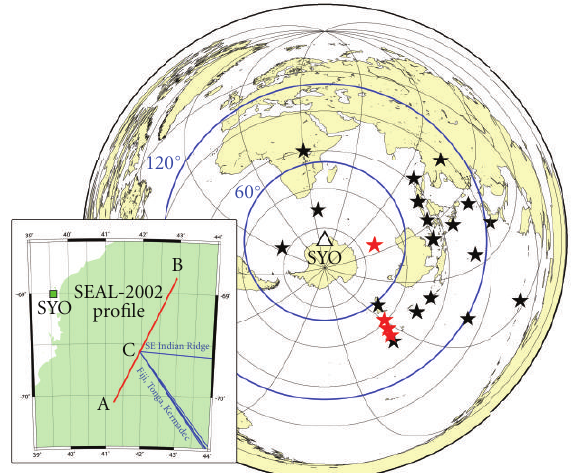
Figure 5: Hypocentral map of the teleseismic events during the SEAL-2002 exploration. Red/black stars indicate events whose waves can be identified/unidentified in the observed records, respectively (corresponding to Table 1). A black triangle indicates SYO. Blue circles show great circle distances of 60 and 120 degrees from SYO. (inset) An extended map of the studied area on the Mizuho Plateau (red line: SEAL-2002 profile, blue lines, incoming ray paths from observed teleseismic events).